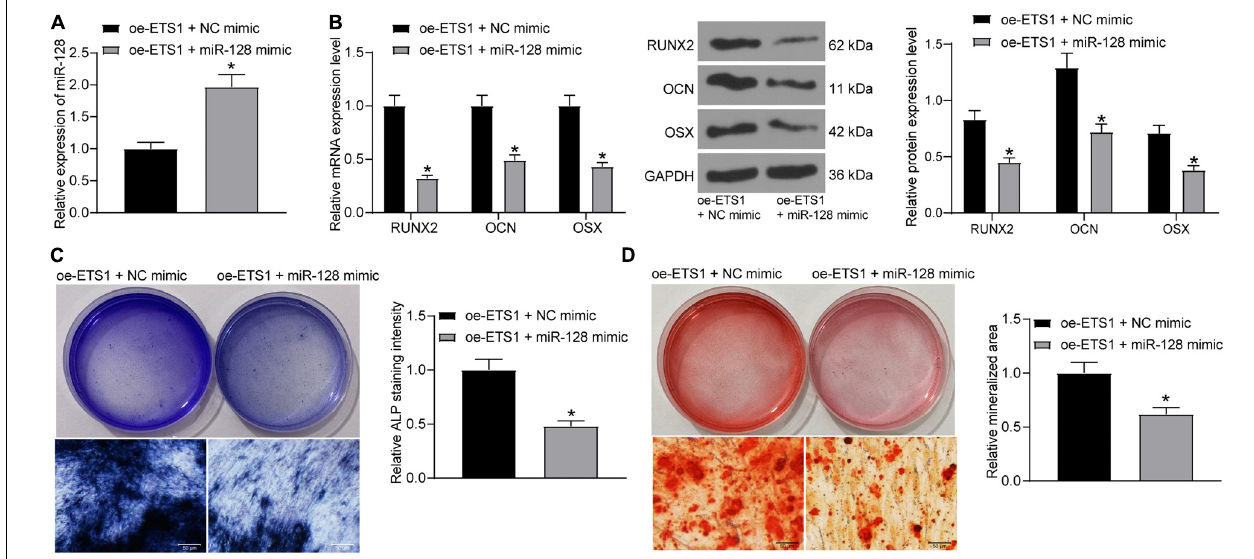
FIGURE 4 | Overexpression of miR-128 blocks the promotion of ETS1 on osteogenic differentiation. (A) Transfection efficacy of miR-128 mimic determined by RT-qPCR (unpaired t -test, * p < 0.05). (B) mRNA and protein levels of osteogenic markers including OCN, OSX and RUNX2 in cells determined by RT-qPCR and western blot analysis, respectively (two-way ANOVA, * p < 0.05). (C) ALP concentration in MC3T3-E1 cells measured by ALP staining (unpaired t -test, * p < 0.05). (D) Calcareous accumulation in MC3T3-E1 cells measured by ARS staining (unpaired t -test, * p <